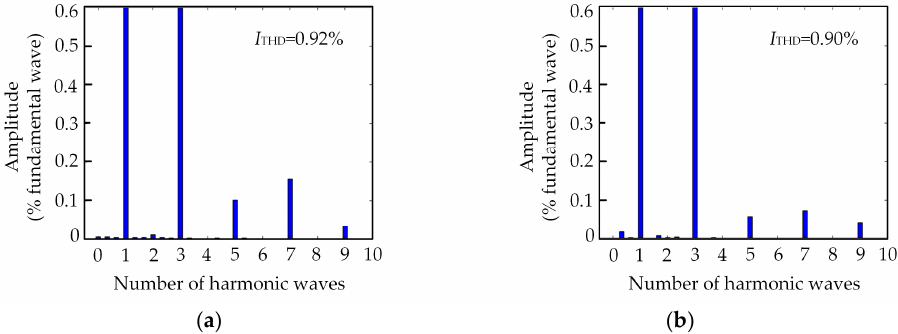
Figure 18. The total harmonic distortion of the output current at cos φ = 0.954 ( N = 8). ( a ) The proposed modulation approach, ( b ) the conventional modulation approach.